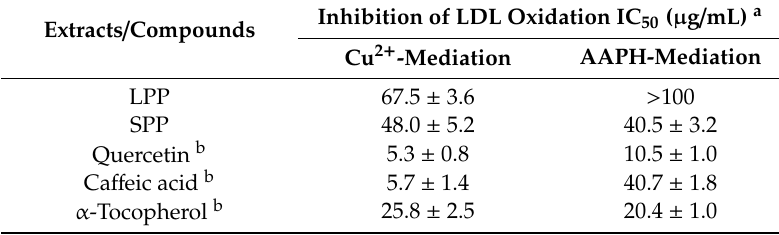
Table 1. E ff ects of LPP and SPP extracts on the formation of oxidation against Cu 2 + -mediated LDL